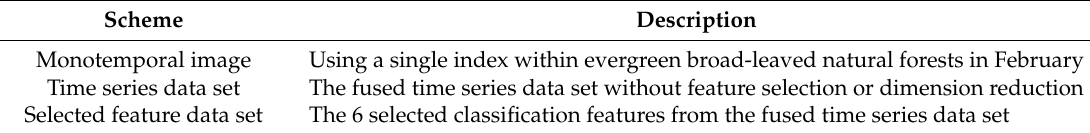
Table 7. Summary of classification